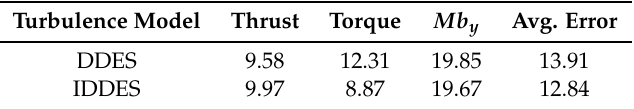
Table 3. Relative error for integral quantities, for comparison between DDES and IDDES turbulent approach. Values are presented in percentage [%] unless indicated